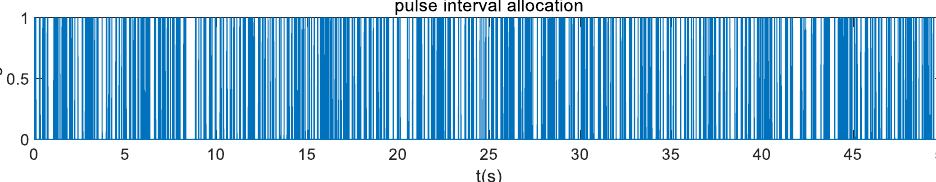
Figure 8. Pulse interval allocation.